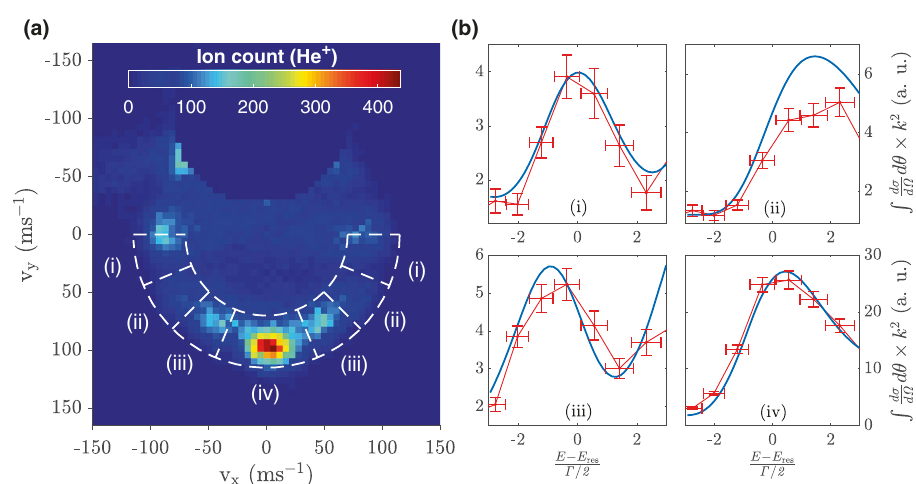
Fig. 1 Angle-resolved resonance pro fi les in He*-D 2 elastic scattering. a A VM image is shown at collision energy 4.7 K where different angular sectors are marked as regions (i) – (iv) on the annulus depicted by white-dashed semicircles. The x and y- axes represent the velocity of He * in the centre-of-mass frame. The y -axis is the direction of the relative velocity vector and the forward direction ( θ ¼ 0 (cid:3) ) points up. b The experimental (red) and theoretical (blue) angle-resolved energy-dependent cross sections ´ k 2 (where k ¼ p = _ and p is the incident momentum of the colliding pair) are shown in the vicinity of the orbiting resonance dominated by l ¼ 6 ( E res = 4.8 K). The red lines join the experimentally obtained data points. The x -axis represents E (cid:2) E res Γ = E Γ is the resonance width. The error bars show standard deviation in experimental data res is the resonance energy and